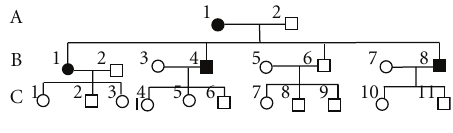
Figure 1: (family